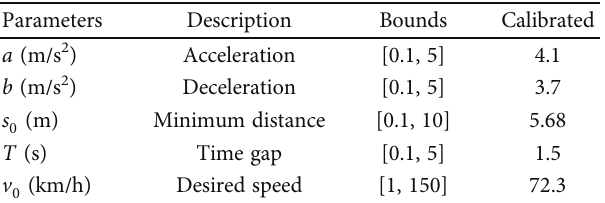
Table 2: IDM parameter calibration results.